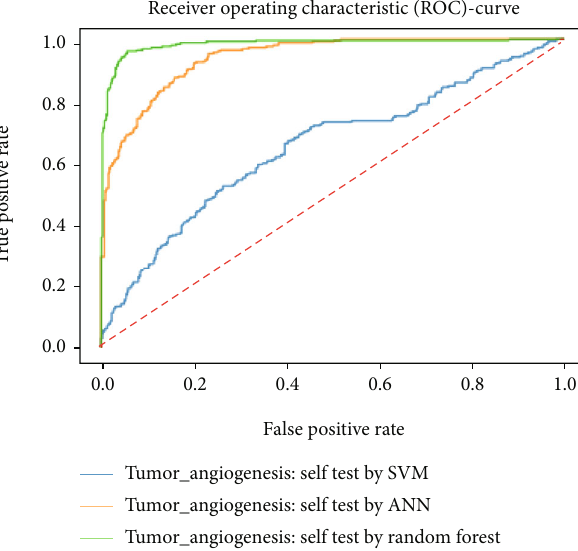
Figure 9: Jackknife testing comparison.